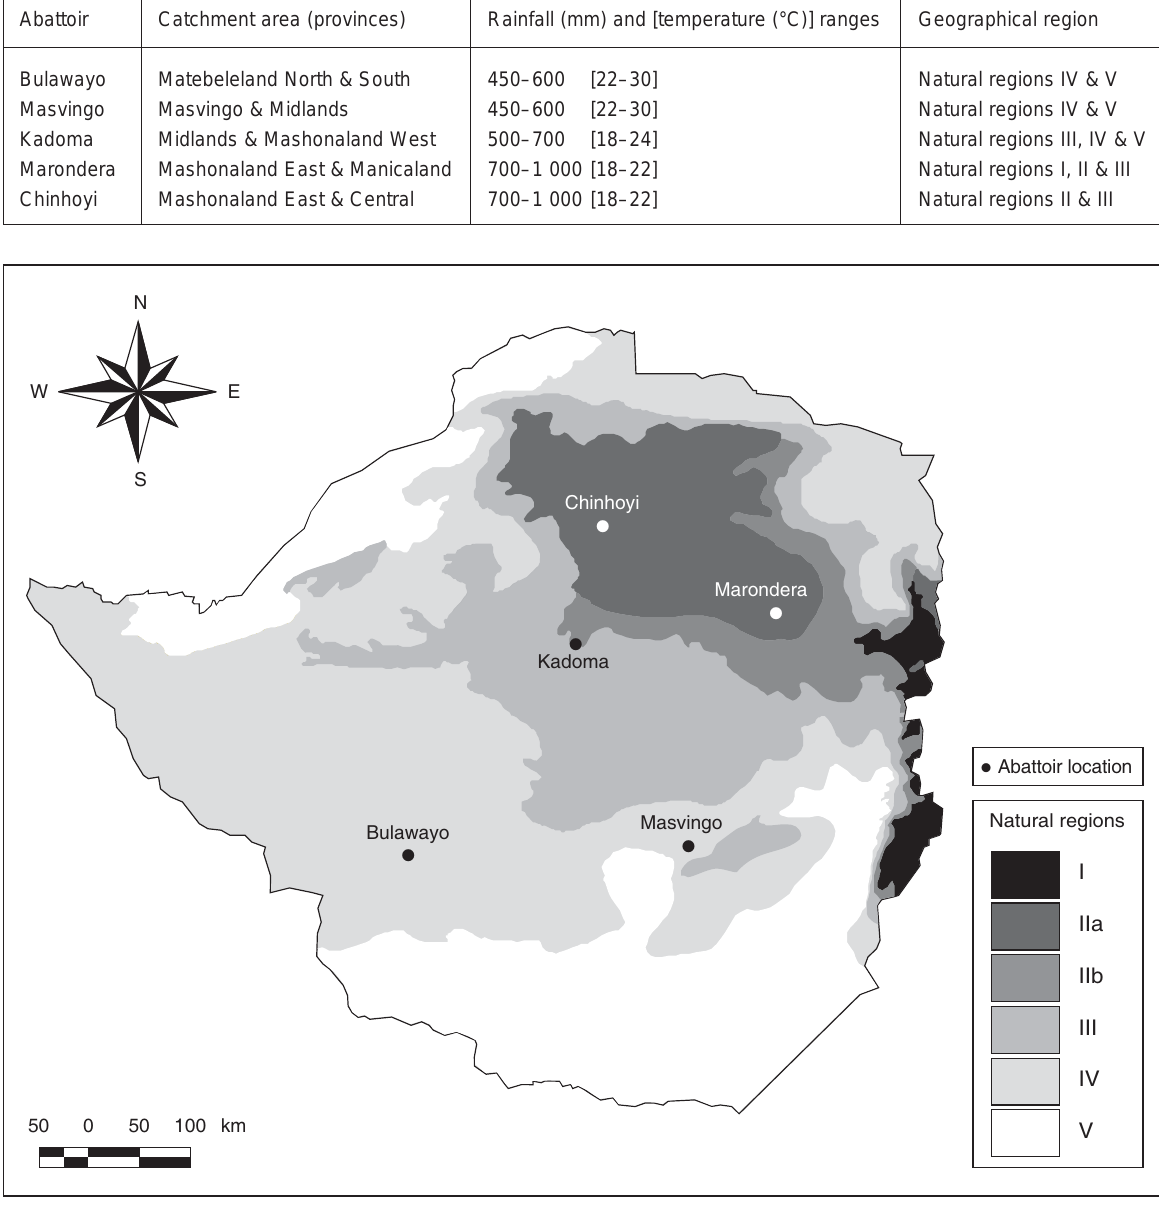
FIG.1 Location of abattoirs in the different natural regions